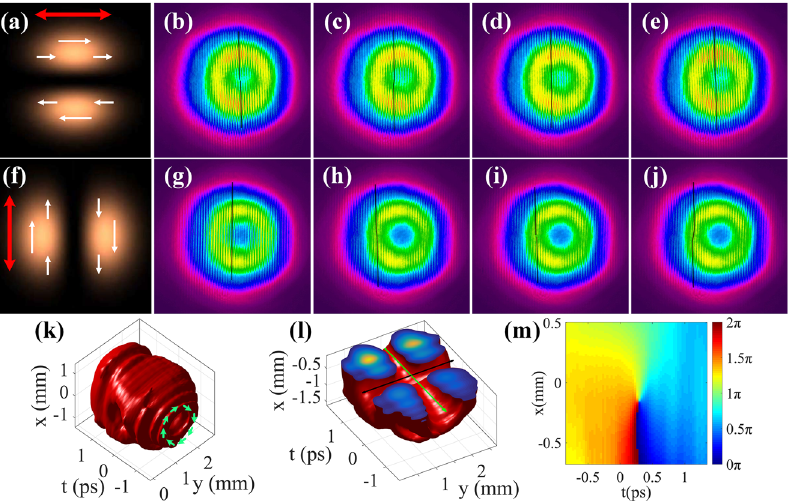
Figure 5: Experimental results for characterizing azimuthally polarized STOV. (a) Diagram of the pattern for the horizontally polarized component within an azimuthally polarized object beam. (b – e) The interference patterns at several representative temporal locations of the object wavepacket when the probe beam is horizontally polarized. (f) Diagram of the pattern for the vertically polarized component within an azimuthally polarized object beam. (g – j) The interference patterns at several representativetemporallocationsoftheobjectwavepacketwhentheprobebeamisverticallypolarized.Thereconstructed3Dspatiotemporal wavepacket(k)anditscut-throughview(l).(m)Theexperimentallyreconstructedspatiotemporalphasedistribution.Theredarrowsin(a)and (f) indicate the polarization direction of the probe beam, and the white arrows indicate the polarization direction of corresponding compo- nents within object beam. The black lines in (b) – (e) and (g) – (j) indicate the relative location between the upper and lower fringes in each interference pattern. The green arrows in (k) represent the azimuthal polarization of the STOV. The green and black lines in (l) indicate the traces of the polarization and OAM singularities,